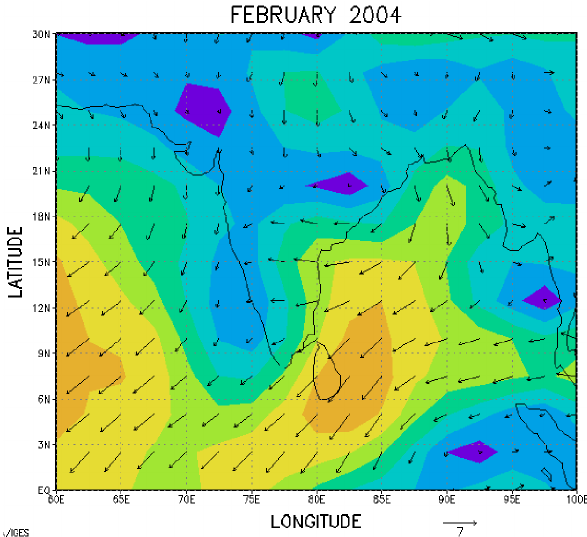
Fig. 9. Mean isotachs (ms − 1 ) at 850hPa level over peninsular India for February 2004 obtained from NCEP/NCAR